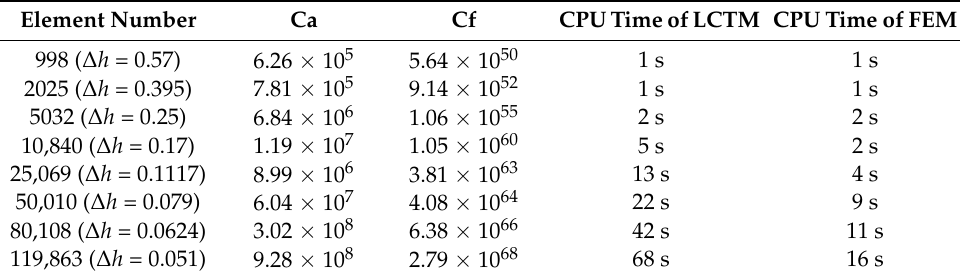
Table 5. Condition number Cf and Ca and time cost of LCTM and FEM for each node number.